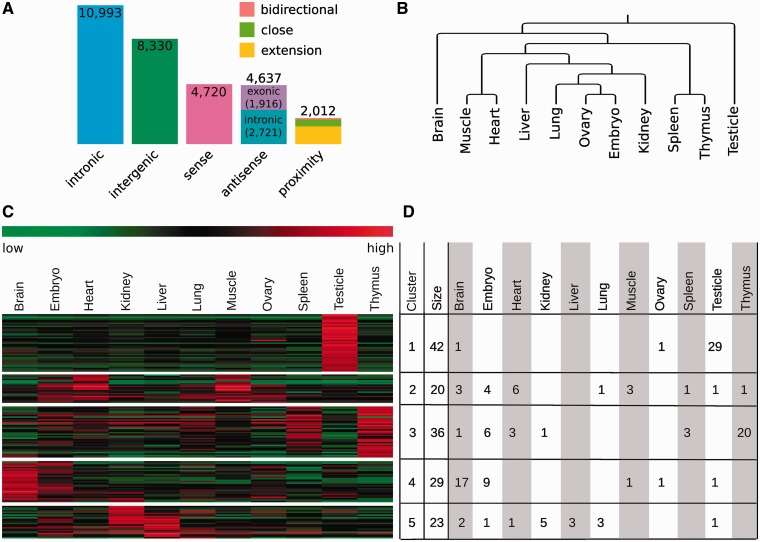
(A) Position of mouse lncRNAs in respect to protein-coding genes from ENSEMBL. Proximate was defined as closer than 1000 bp, but non-overlapping, to the next protein-coding gene. This category intersects into extension (encoded on the same strand, 542), close (opposite strand, 1404) and bidirectional (opposite strand in head-to-head orientation, 66). (B) Dendrogram generated from lncRNA gene expressions of 11 murine tissues. (C) Heat map of the 150 most differentially expressed lncRNAs across 11 different murine tissues. For k-means clustering, we used K = 5. (D) For each lncRNA with GenBank accession number, we looked up the tissue where the cDNA has been originally found. All embryonic libraries have been classified as ‘embryo’, and ‘tongue’ as ‘muscle’ and ‘aorta and vein’ as ‘heart’.